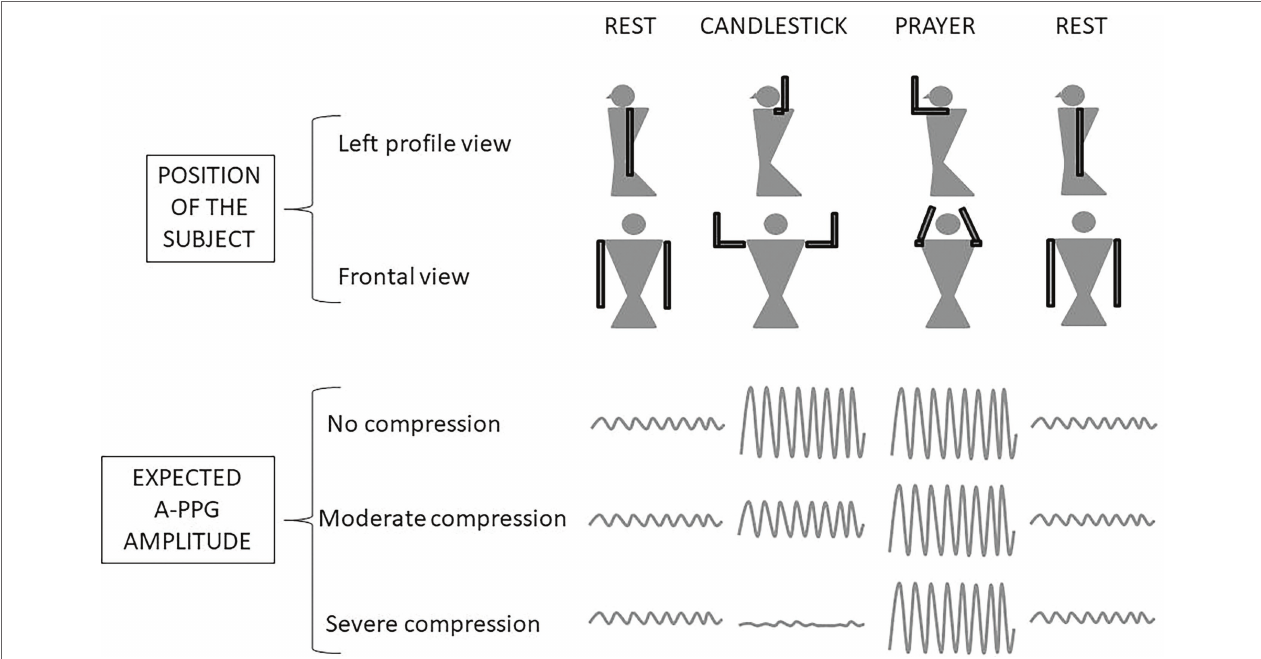
FIGURE 1 | Schematic representation of the Candlestick-Prayer (“Ca + Pra”) procedure and of expected changes in digital arterial photo-plethysmography (A-PPG) pulse amplitude during the different phases. With arm elevation, A-PPG pulse amplitude is expected to increase as a function of hand altitude change relative to heart level. Pulse amplitude is expected to be the same in the candlestick and prayer positions in normal subjects. A decrease of pulse amplitude with arm elevation was considered to be abnormal and the result of a severe arterial attitudinal compression (occlusion or sub-occlusion). Lastly, in cases of partial (mild to moderate) compression, the amplitude observed during the candlestick position remains lower than the one observed in the prayer